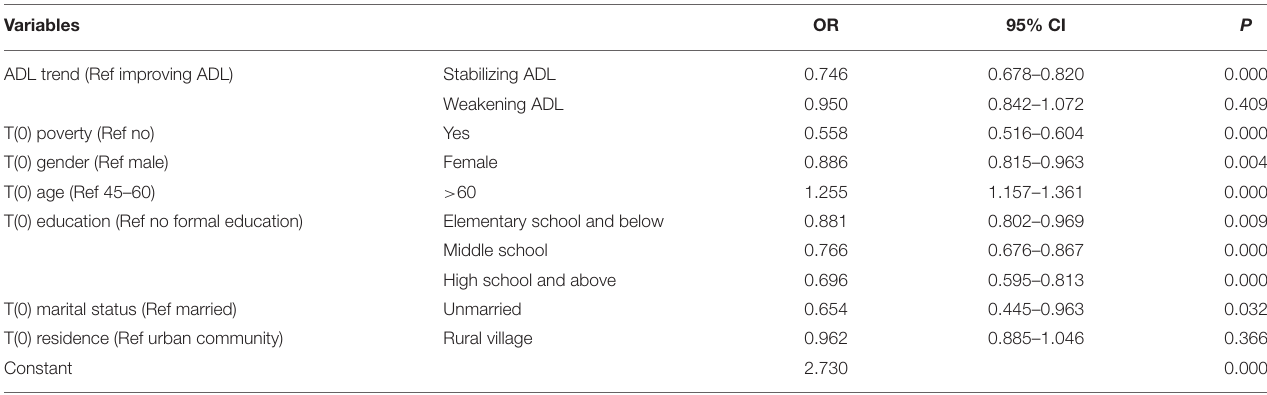
TABLE 5 | Catastrophic health expenditure trend models on ADL trend and control